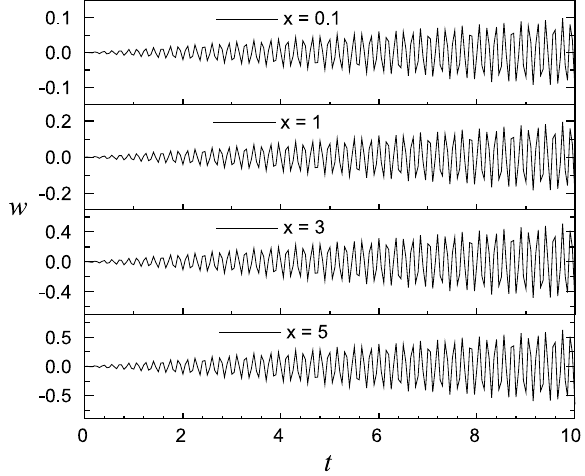
Fig. 21. Deflection of various points for the simply supported FGPM cylindrical shell imposed by a sinusoidal distributed load as the time increasing, when n = 1 .